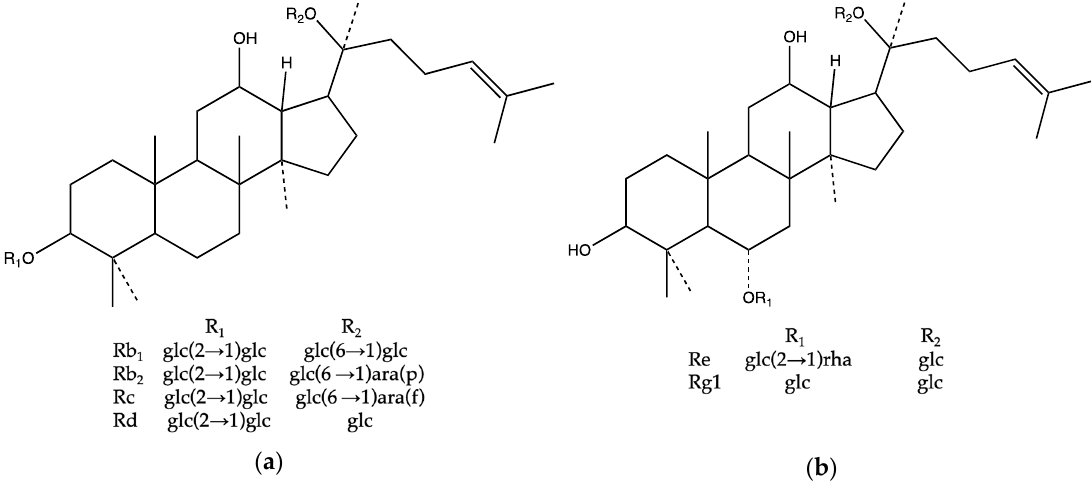
Figure 1. Structures of ginsenosides: ( a ) panaxadiol group and ( b ) panaxatriol group. The main ginsenosides used in this study are shown as follows: Glc, glucose; ara (p), arabinose in the pyranose form; ara (f), arabinose in the furanose form; and, rha, rhamnose.